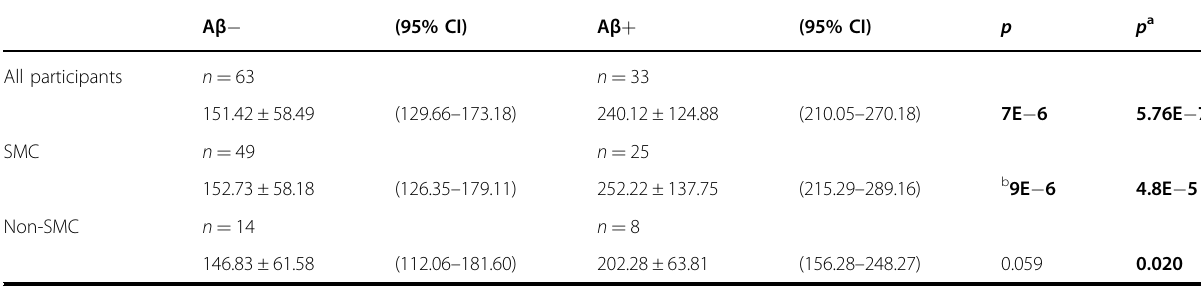
Table 2 Comparison of plasma GFAP between A β − and A β +